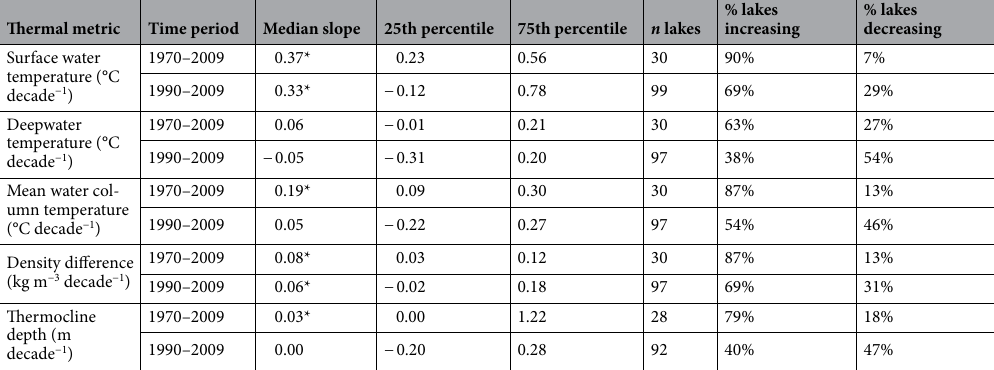
Table 3. Summary statistics of temporal trends for the thermal metrics across both time periods. Summaries were based on Sen’s slopes from each individual lake. Asterisks indicate overall significant change across all lakes (1-sample Wilcoxon rank sum tests, p < 0.05). Percent of lakes increasing and decreasing represents all lakes, and does not necessarily add up to 100% due to a small percentage of lakes with a Sen’s slope of zero.